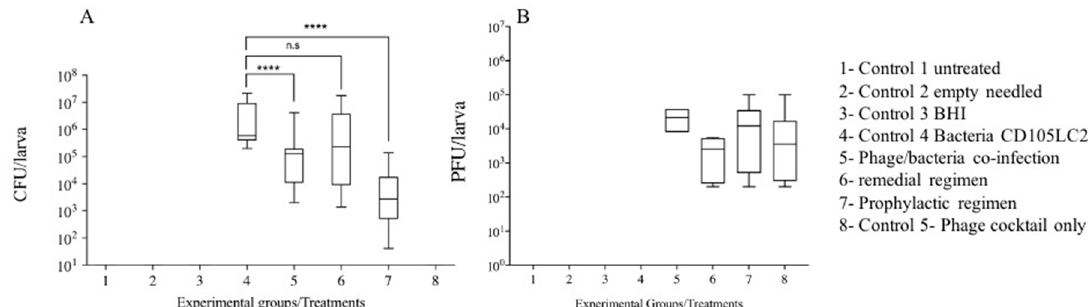
Figure 2. Bacterial and phage load recovered from G. mellonella larvae at the end of the 72nd hour. Four larvae in each of the eight treatment groups were treated with 10 5 CFU / larva of clinical isolate CD105LC2 culture and / or 10 6 PFU / larva of phage cocktail (in 10 µ L volumes) at time points shown in Table 1. Colonisation was ascertained by recovering ( A ) C. difficile from the guts of insects on CCEY selective plates and ( B ) phages using double BHI agar method. The lowest amount of bacteria was recovered from the prophylactic treatment (compared to the bacterial control), indicative of successful phage infection ( p < 0.0001). The co-infection (with phage and bacteria) treatment also yielded a reduced bacterial load ( p < 0.0001). The experiment was repeated three times and data were analysed using the Shapiro–Wilk normality test and Mann–Whitney–Wilcoxon test. n.s. = no significant difference, **** = significance at p < 0.0001.